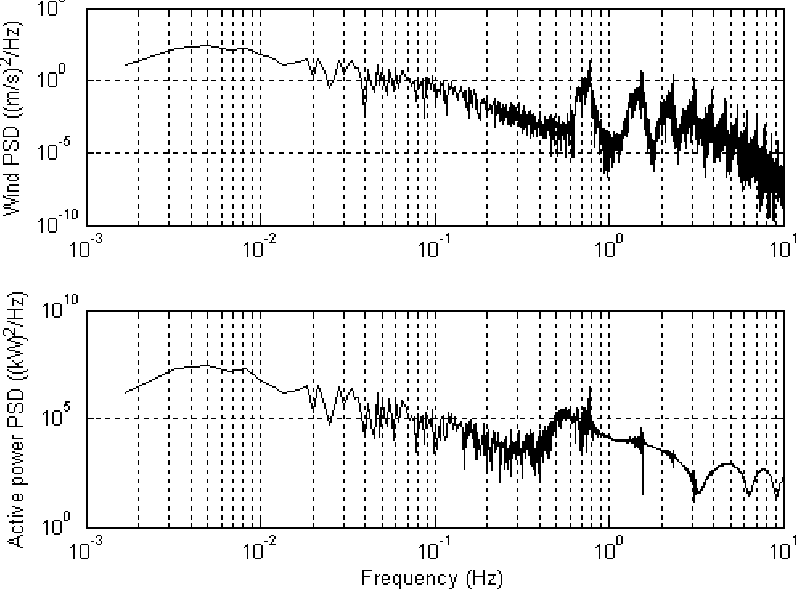
Figure 4. Power spectral density (PSD) of equivalent wind speed and output active power of the wind